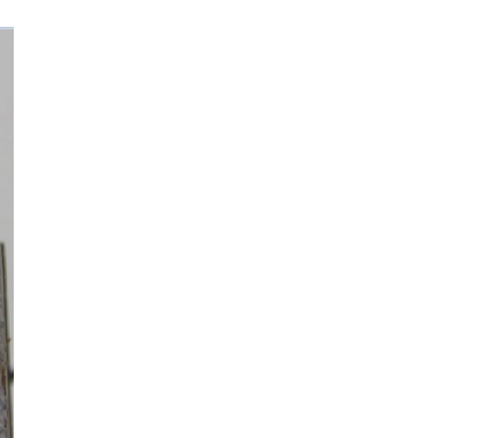
Figure 20. Photograph of a specimen showing another tensile crack from the top surface caused by compression appearing.